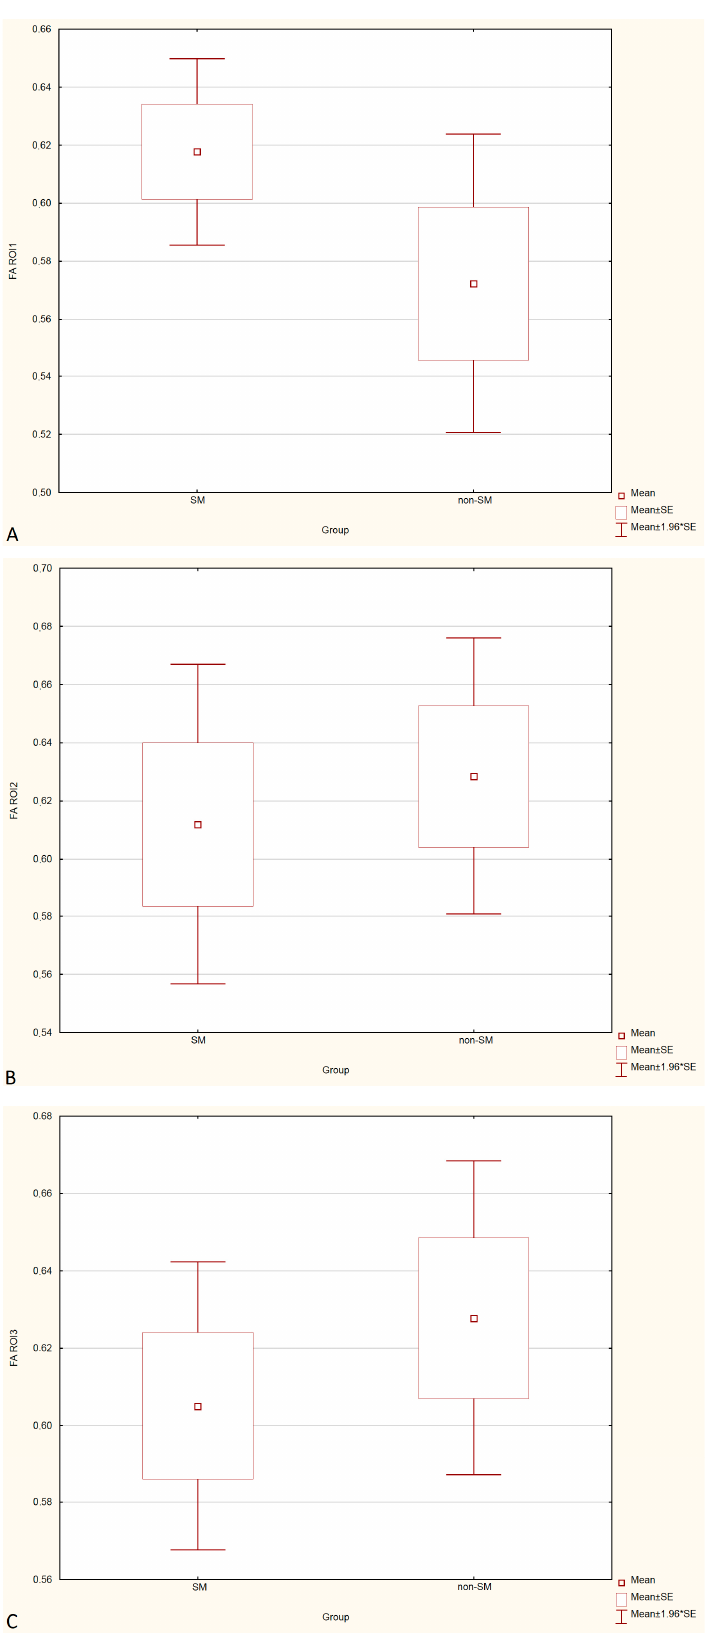
Figure 3. Boxplots comparing FA values in ROI-1 ( A ), ROI-2 ( B ), ROI-3 ( C ) between the SM and non-SM groups.